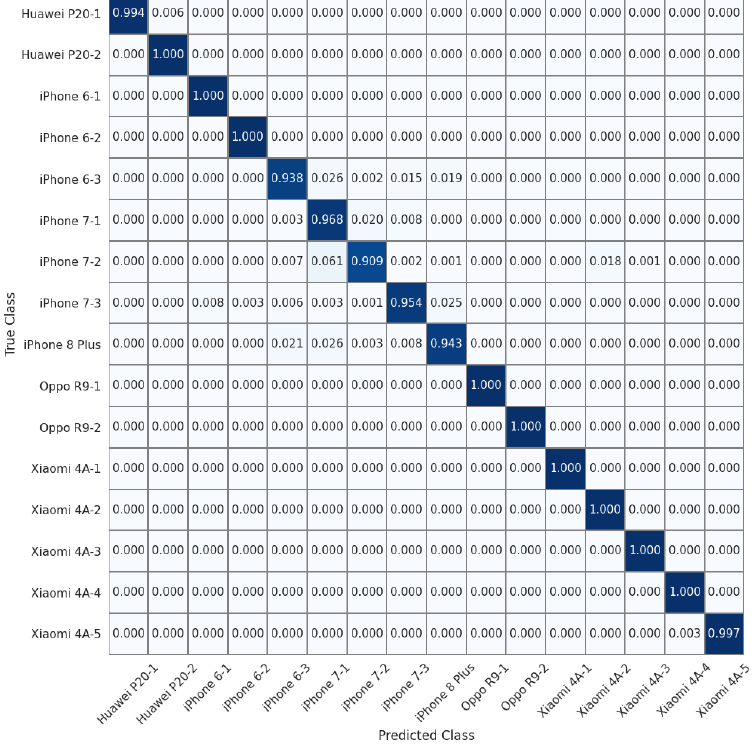
Figure 5. Normalized confusion matrix for source-camera identification based on randomly sampled images extracted from original images for 16 devices of 6 different models in the Daxing